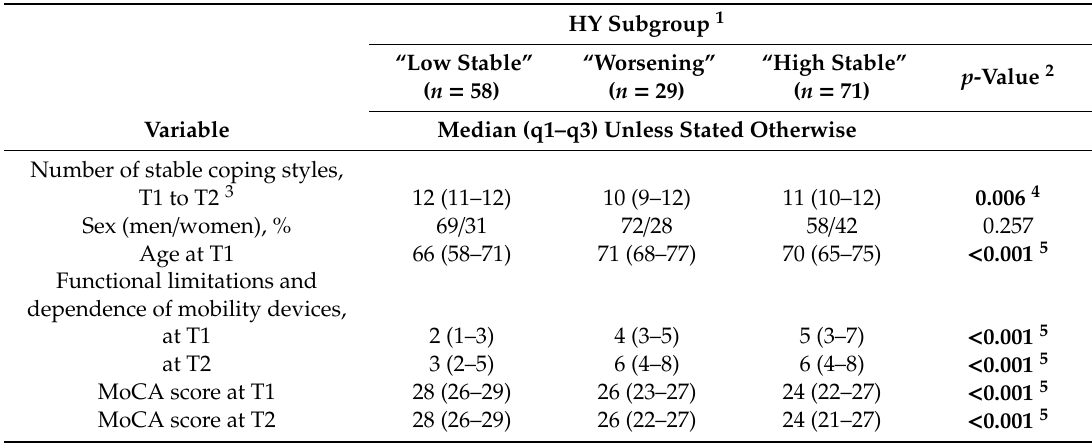
Table 4. Comparison between Hoehn and Yahr (HY) subgroups, with regard to stability of coping styles, personal factors, functional limitations and cognitive functioning.